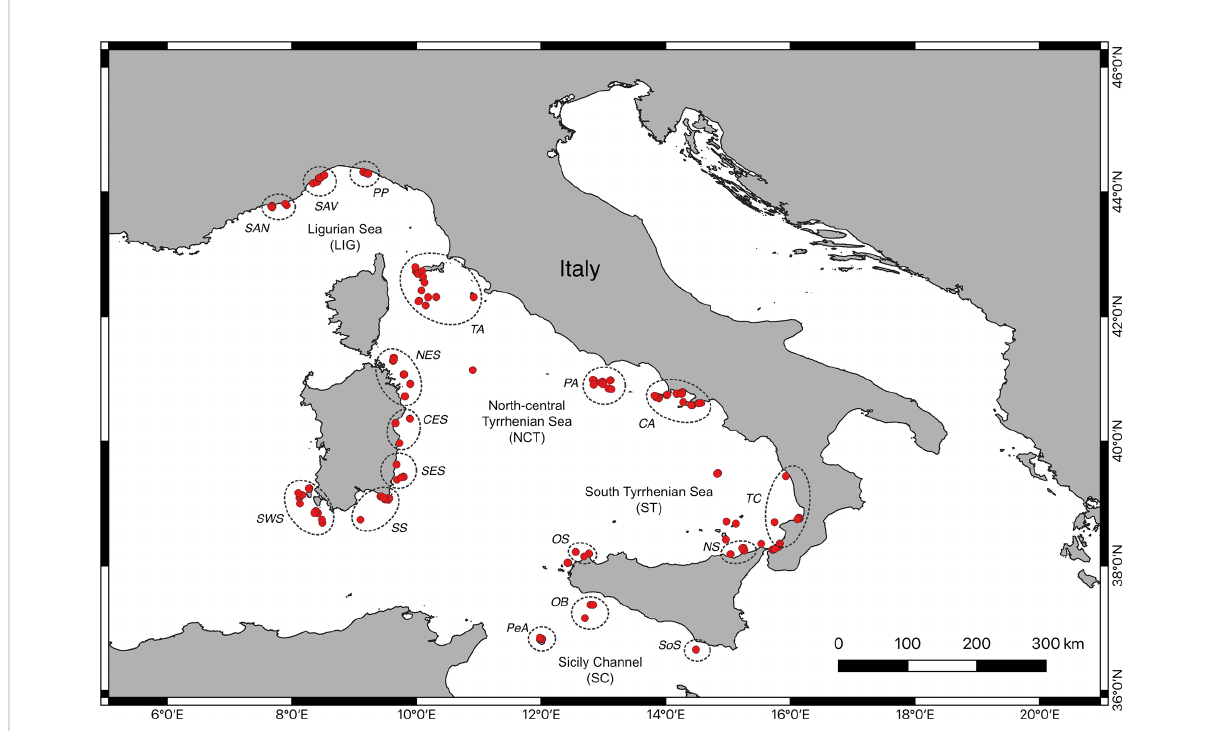
FIGURE 1 Map of the study area with location of the sites with red coral (red dots) grouped per coral area (dashed circles). For coral areas ’ codes, refer to Table